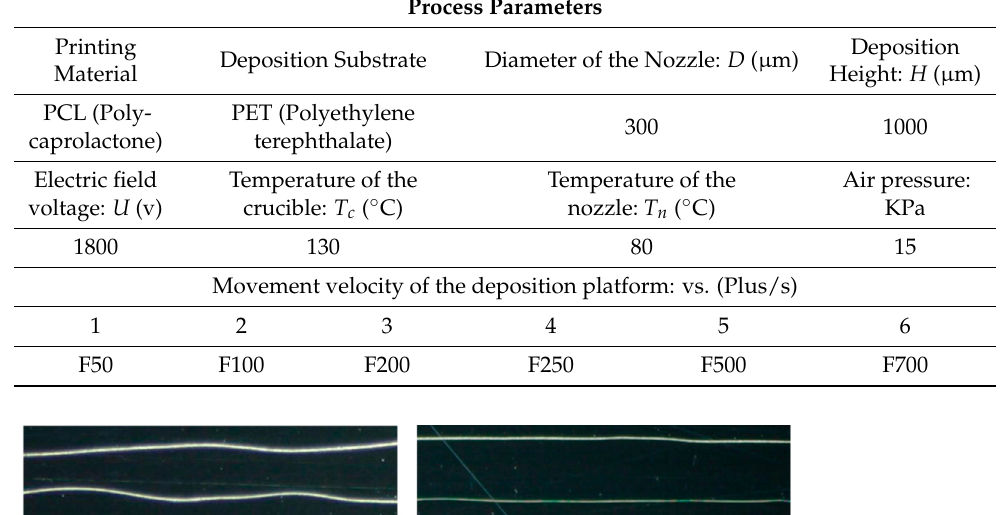
Table 3. The process parameters of printing deposition lines.